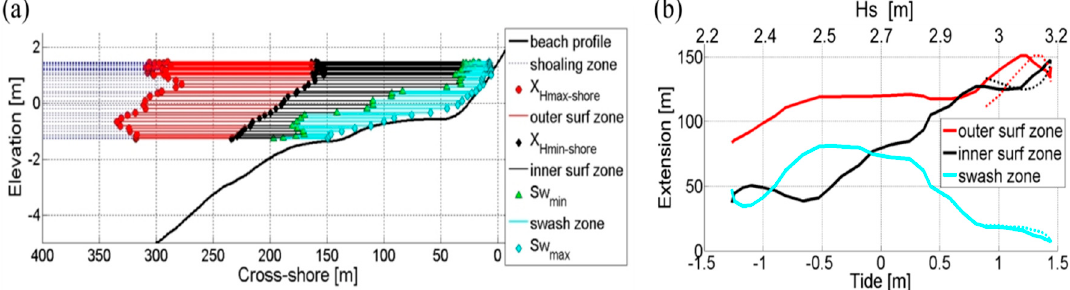
Figure 8. Wave transformation domains spatial variation at Ribeira d’Ilhas on 29th of March. ( a ) Plot of the wave transformations domains extent over the beach profile, at the time-correlated tidal level. ( b ) Extension of inner, outer surf and swash zone in respect to wave significant height and tidal elevation. Dashed lines indicate ebb tide